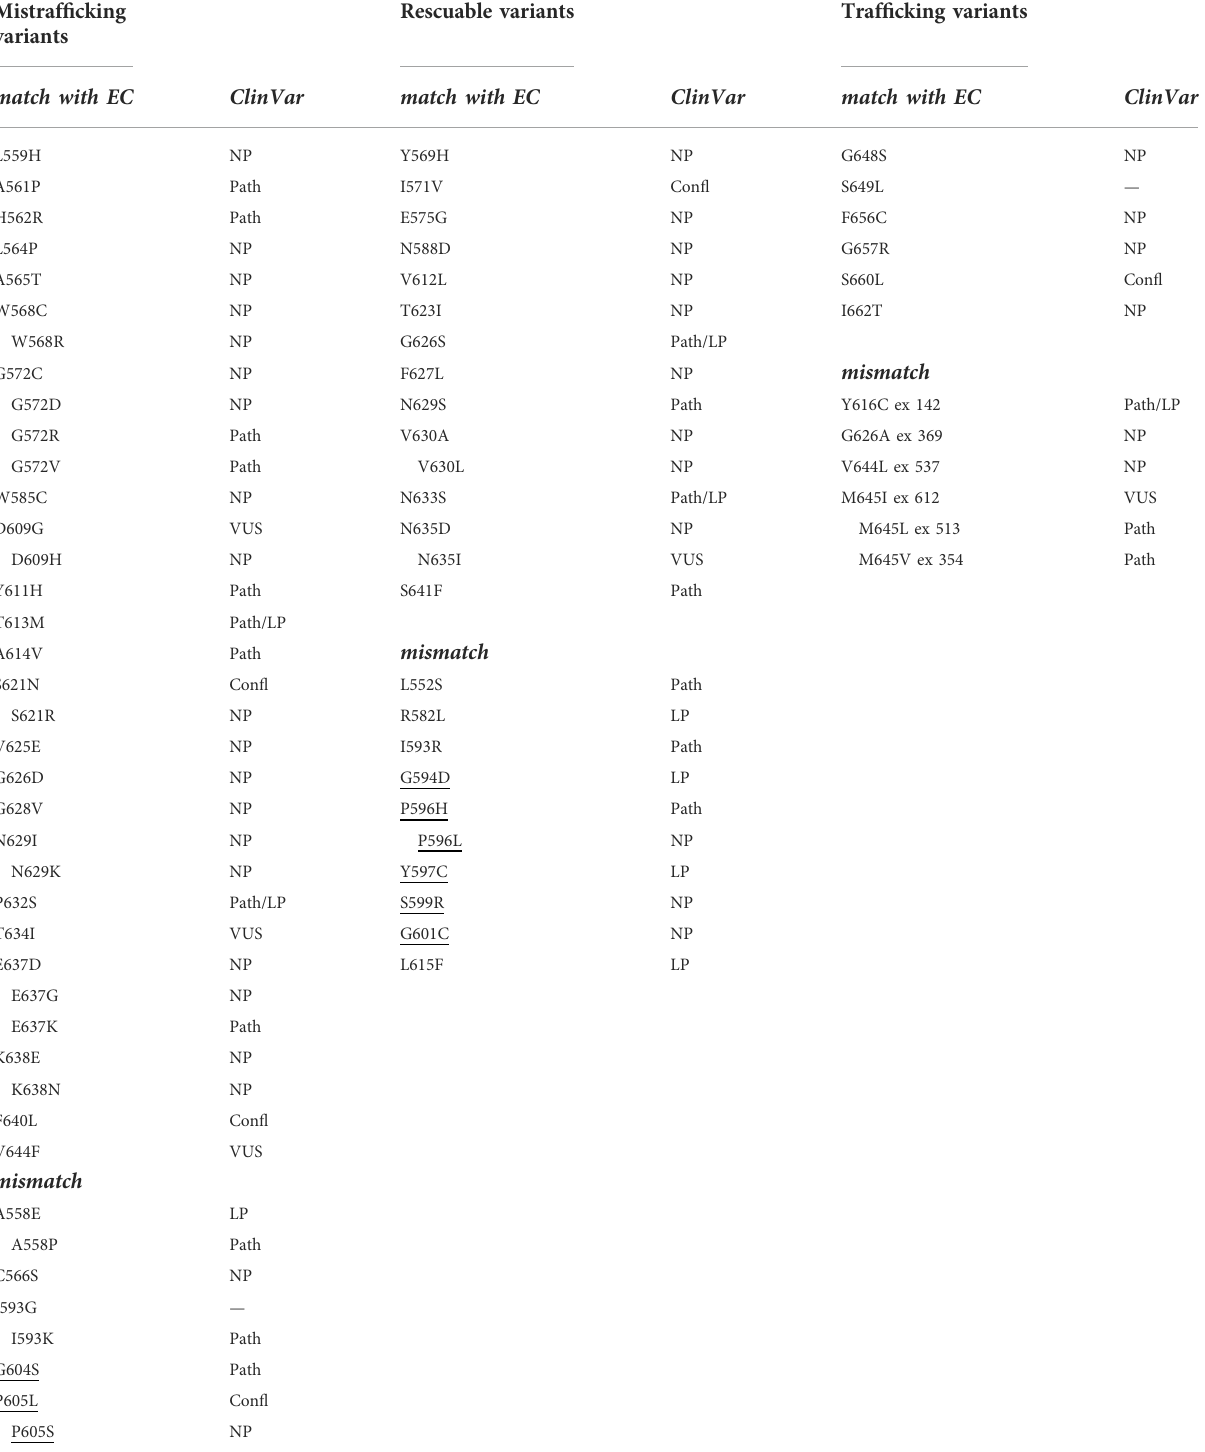
TABLE 2 Comparison of EC data with experimental hERG traf fi cking data from Anderson et al. (2014). Mistraf fi